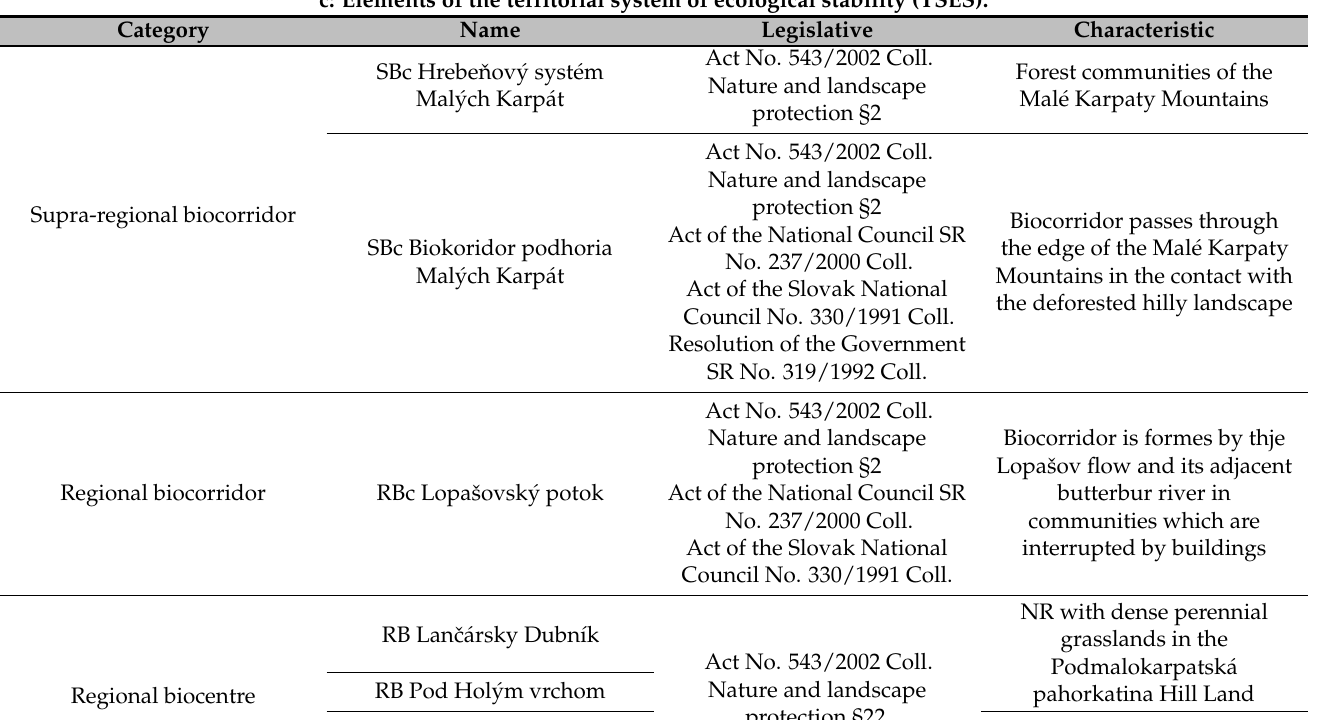
Table 1. Cont. c: Elements of the territorial system of ecological stability